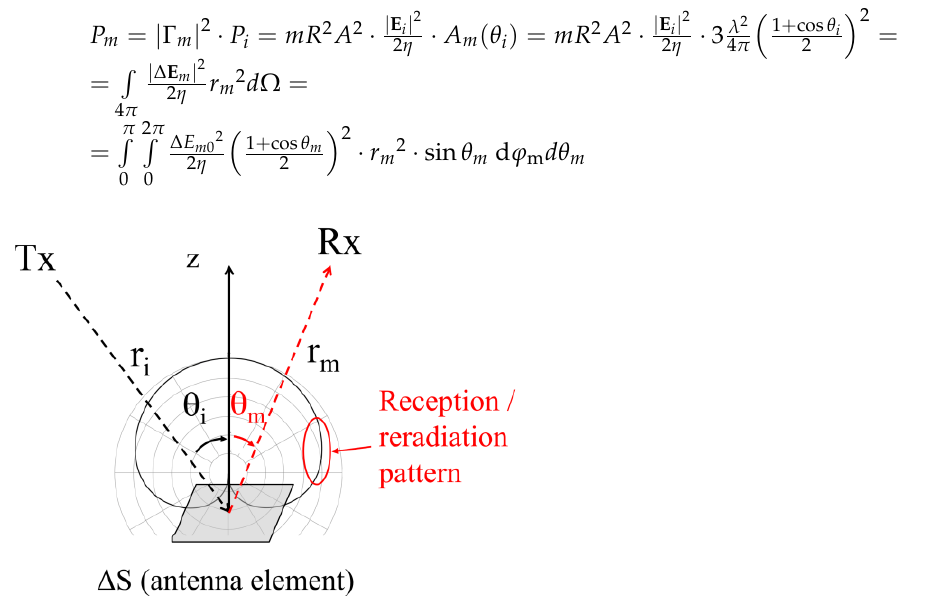
Figure 1. Generic antenna element, its cardioid-shaped radiation pattern, and the Tx/Rx geometry.